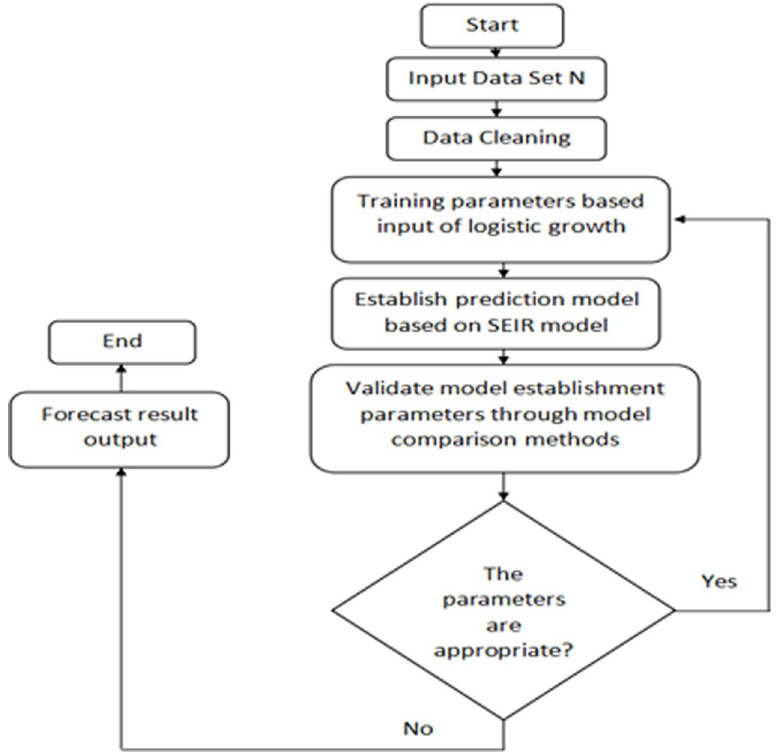
Fig 2. Flowchart of